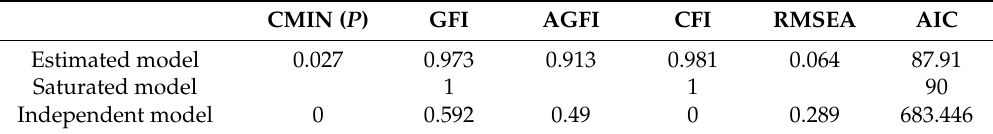
Table 4. Goodness-of-fit scores for the TAG biosynthesis regulatory